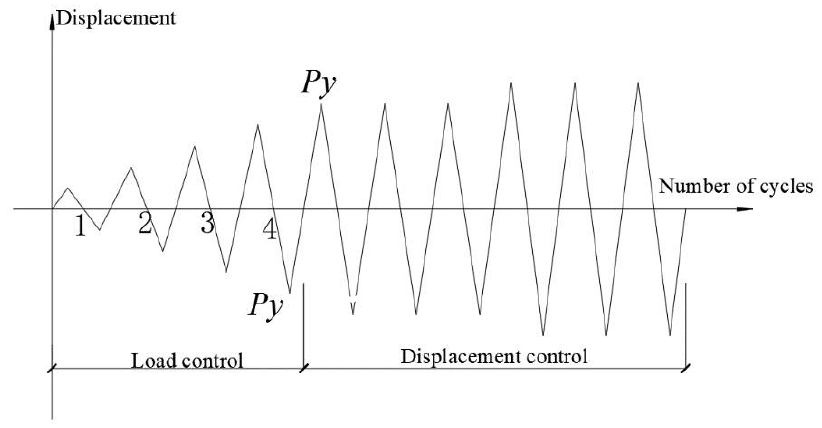
Figure 6. Loading procedure.